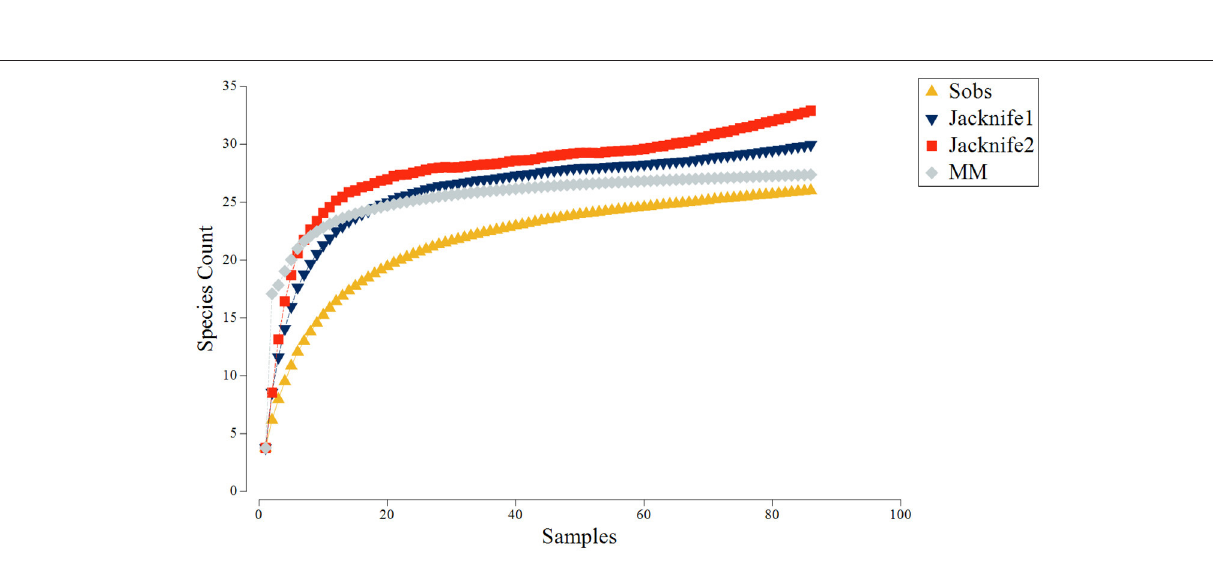
Frontiers in Marine Science |